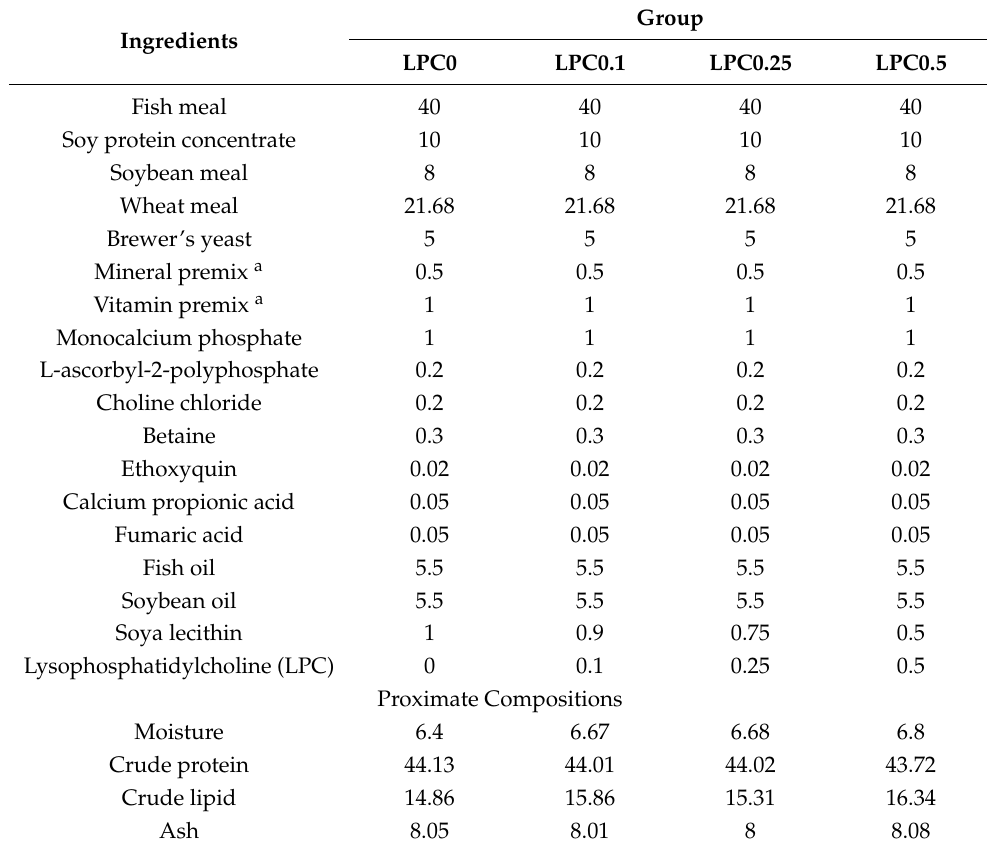
Table 1. Formulation and proximate composition of the experimental diets (% dry